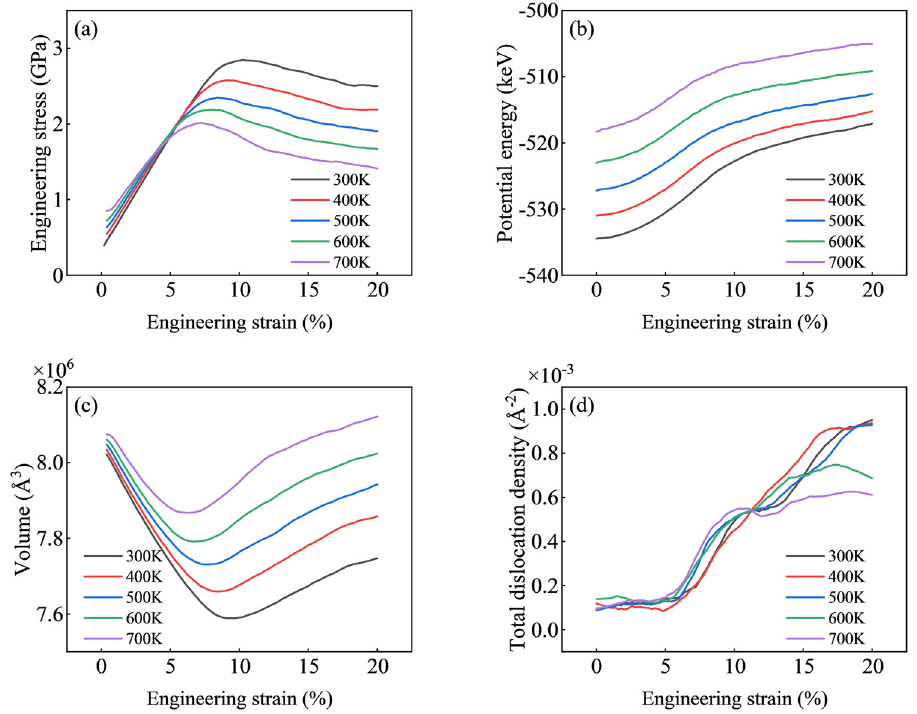
Figure 11: Force energy parameter curve: ( a ) stress – strain curve, ( b ) potential energy curve, ( c ) volume curve, and ( d ) total dislocation density